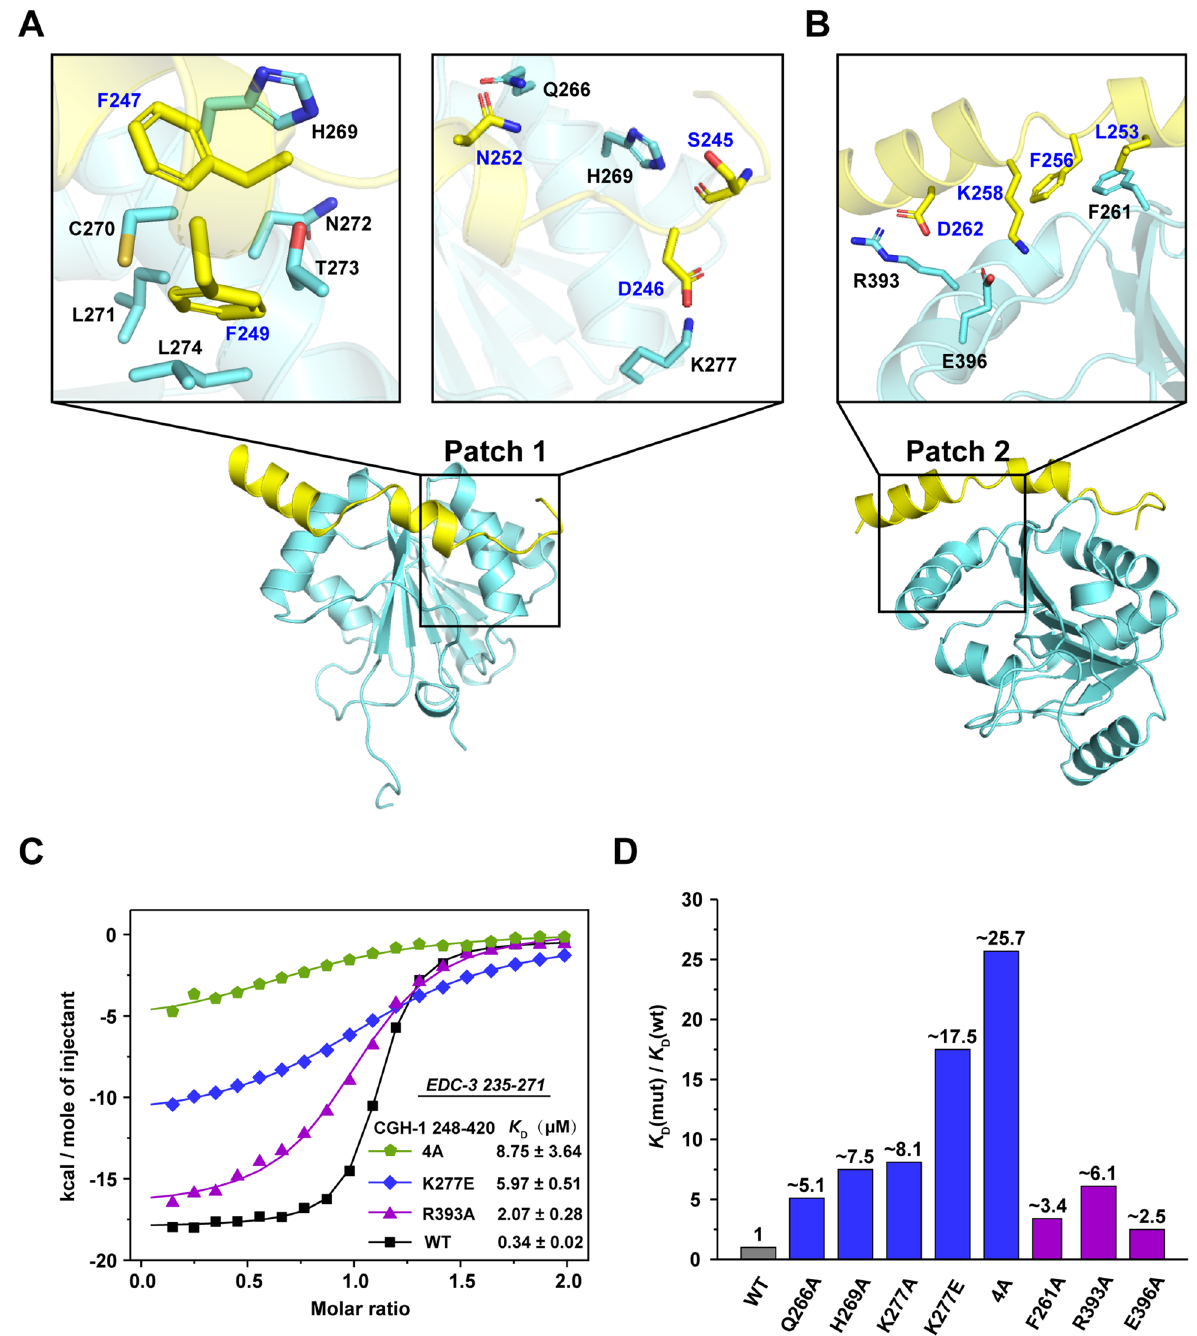
Figure 2. The interface of CGH-1 (cyan) and EDC-3 (yellow). ( A ) Interaction details of the Patch 1. Amino acids are shown as side chains. ( B ) Interaction details of the Patch 2. ( C ) Representative curves of ITC assays. ( D ) Effects for the mutations on the binding affinity between CGH-1 RecA2 domain and EDC-3 FDF-FEK